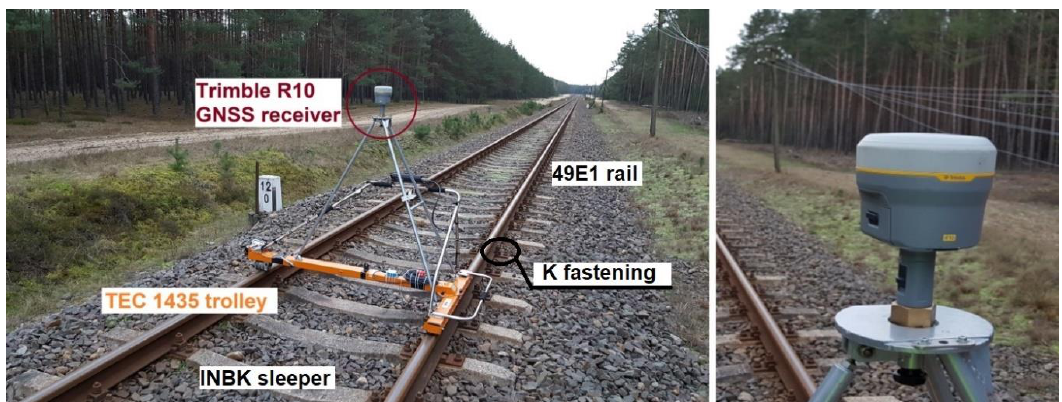
Remote Sens. 2020 , 12 , x FOR PEER REVIEW Figure 3. Measuring set number 1 to measuring using the GNSS technique. Figure 3. Measuring set number 1 to measuring using the GNSS technique.